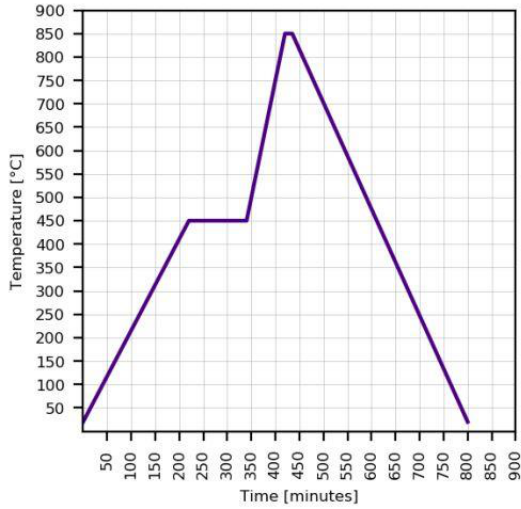
Figure 3. Firing profile for the Ferro A6M-E tape material without forced cooling.